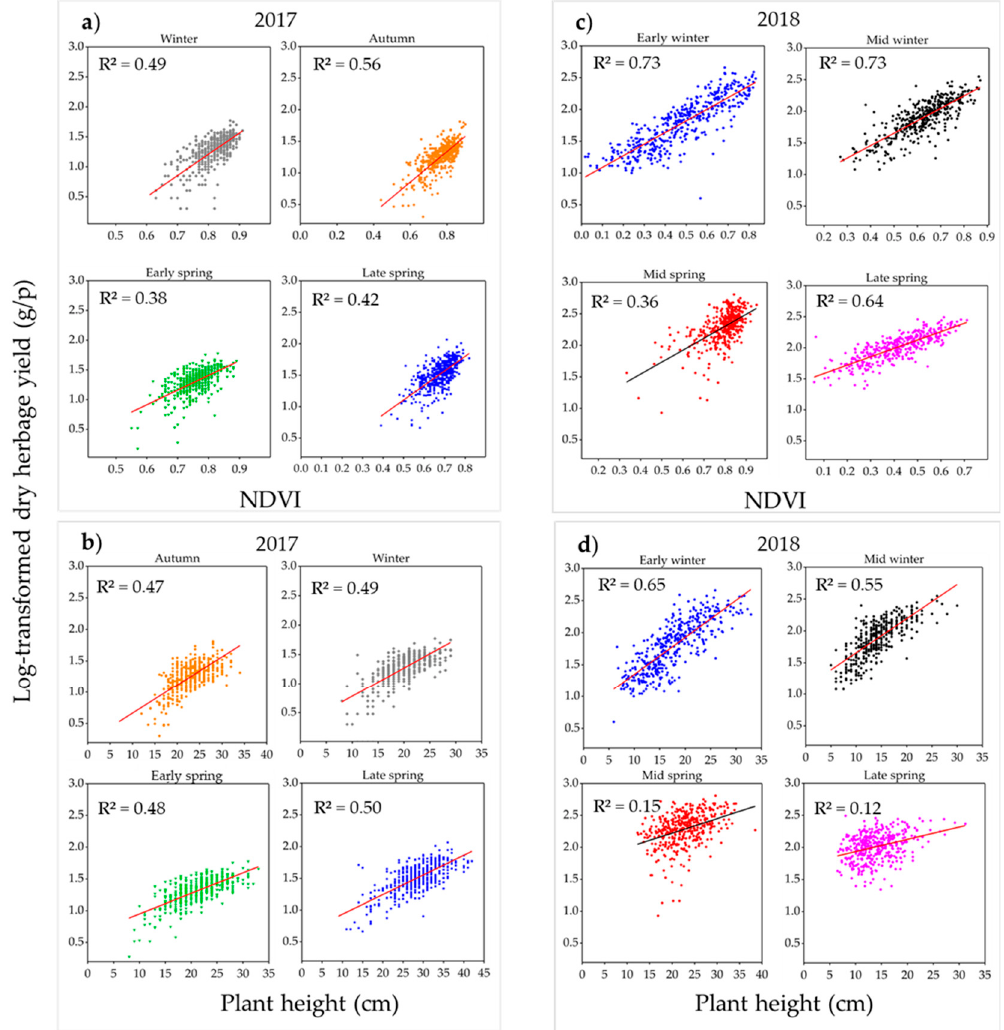
Figure 6. Scatterplots of ( a ) NDVI extracted from UAS-based multispectral imaging vs. log-transformed dry herbage yield measurements of single plants in four seasons of the 2017 dataset; ( b ) plant height measured versus log-transformed dry herbage yield measurements of single plants in four seasons of the 2017 dataset; ( c ) NDVI extracted from UAS-based multispectral imaging vs. log-transformed dry herbage yield measurements of single plants in four seasons of the 2018 dataset; ( d ) plant height measured versus log-transformed dry herbage yield measurements of single plants in four seasons of the 2018 dataset. p -value < 0.001 for all regression equations.